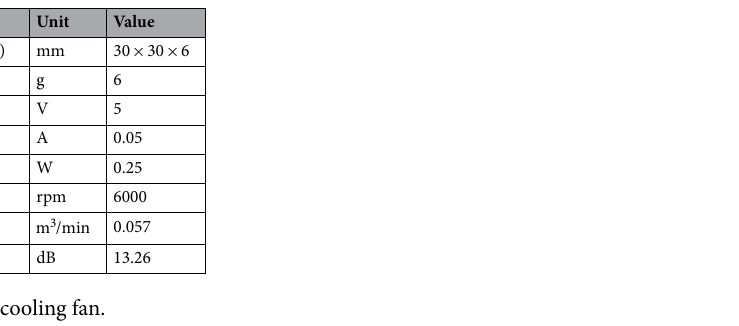
Table 2. Specification of cooling